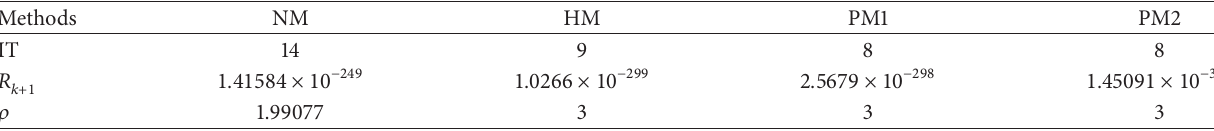
Table 1: Results of comparisons for Example 5 using 𝑋 0 = 𝐴 .